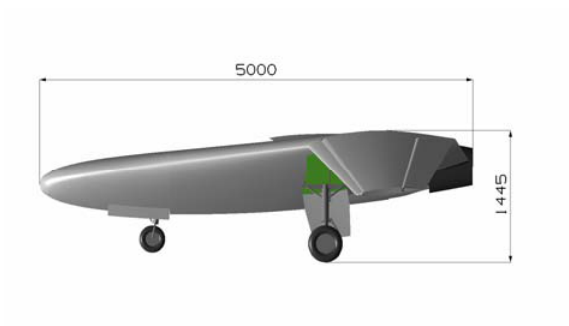
Fig. 6. PW-124 – top view Fig. 7. PW-124 – side view (length and height in